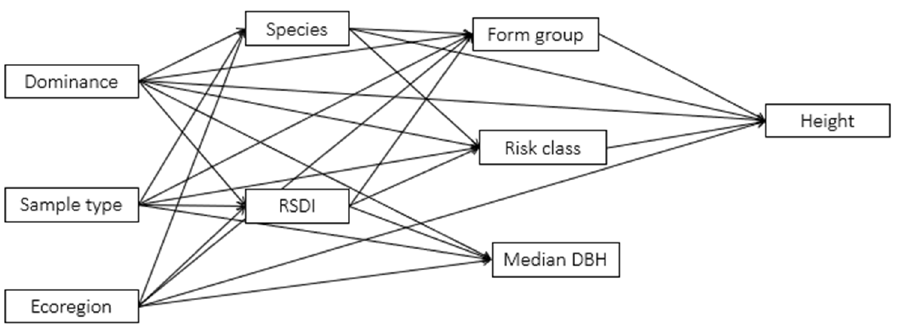
Figure 2. Relationships analyzed at plot and tree level.